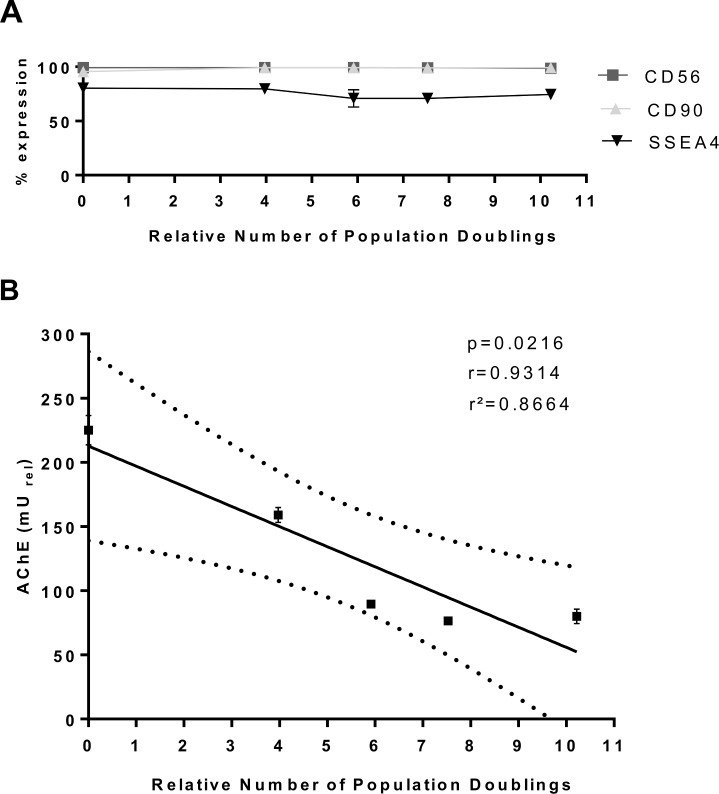
Cell doubling and AChE activity.Effect of cell doubling numbers on cell surface marker expression (CD56, CD90, SSEA-4) (A). AChE activity measured 6 days after differentiation of cells harvested after a total culture time of 6 days with differing numbers of medium changes during the cultivation period leading to different growth kinetics was correlated with the relative number of population doublings over 6 days of culture. Pearson linear regression analysis led to a p-value of p = 0.0216, a correlation coefficient of r = 0.9314 and a coefficient of determination of r2 = 0.8664. 95% confidence intervals are shown as dotted line (B). Data presented as mean±SEM of three individual experiments.